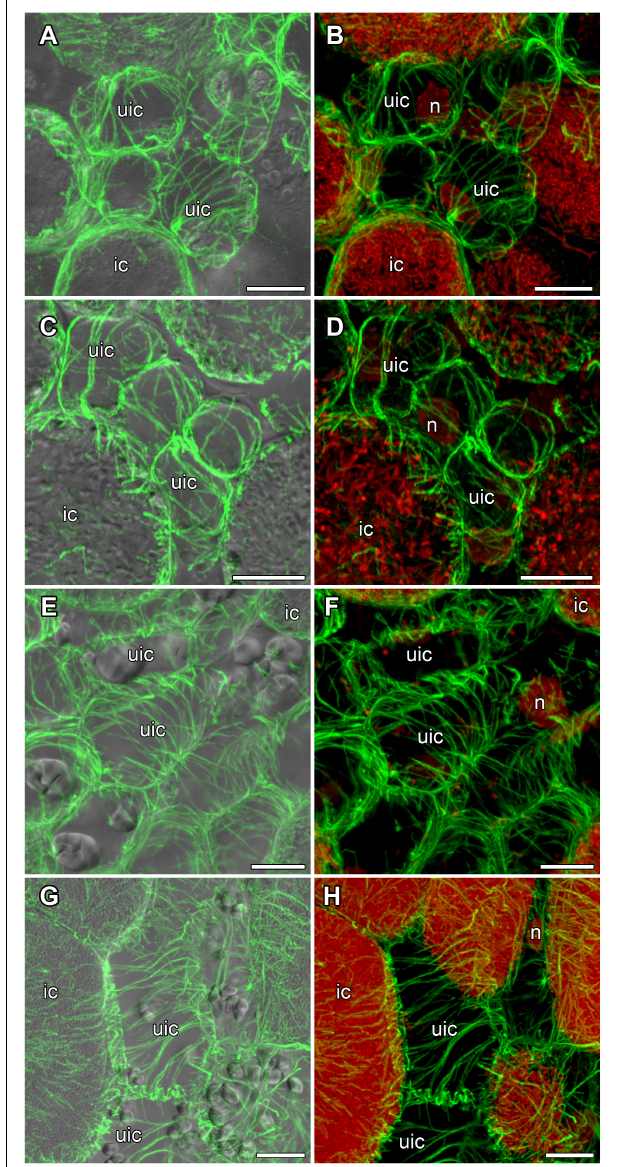
FIGURE 5 | Cortical microtubule organization in uninfected cells of G. max (A,B) , G. soja (C,D) , P. vulgaris (E,F) , and L. japonicus (G,H) nodules. ic, infected cell; uic, uninfected cell; n, nucleus. Confocal laser scanning microscopy of (A–F) 50 µ m and (G,H) 35 µ m longitudinal vibratome sections. Immunolocalization of tubulin (microtubules), green channel; DNA staining with propidium iodide (nuclei and bacteria), red channel. (A,C,E,G) Merged images of a single optical section of differential interference contrast and maximum intensity projection of optical sections in the green channel. (B,D,F,H) Maximum intensity projections of (B) 45, (D) 55, and (F,H) 50 optical sections in green and red channels. Scale bar = 10 µ